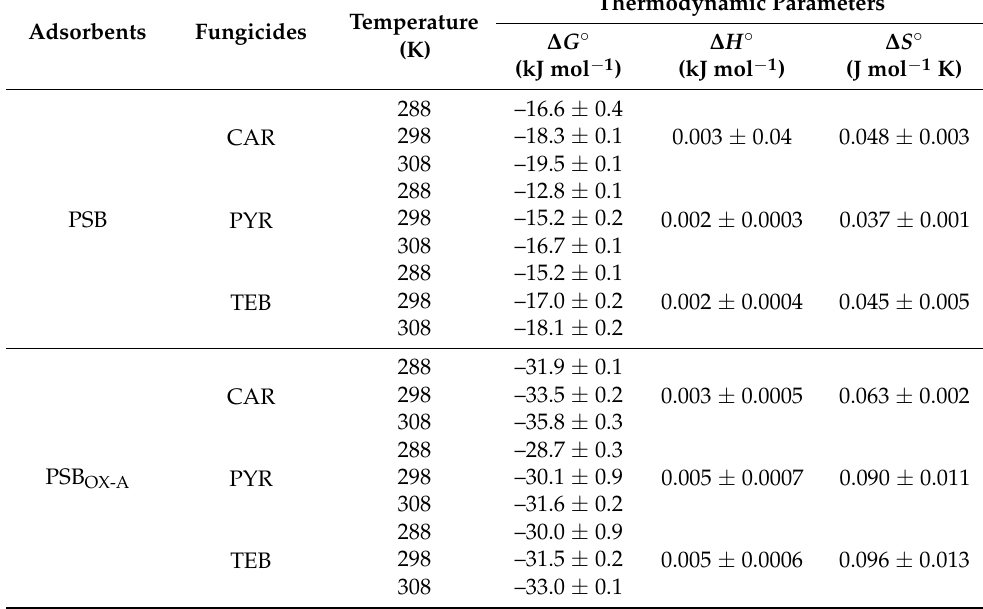
Figure 8. Effects of temperature on the adsorption of fungicides by ( a ) the PSB and ( b ) PSB OX-A (agitation speed = 150 rpm; contact time = 24 h; absorbent dosage = 50 mg L − 1 ; initial concentration of each fungicide = 10 μ M; pH = 7.0). Table 5. Thermodynamic parameters of fungicides adsorption onto PSB and PSB OX-A (agitation speed = 150 rpm; contact time = 24 h; absorbent dosage = 50 mg L − 1 ; initial concentration of each fungicide = 10 µ M; pH =